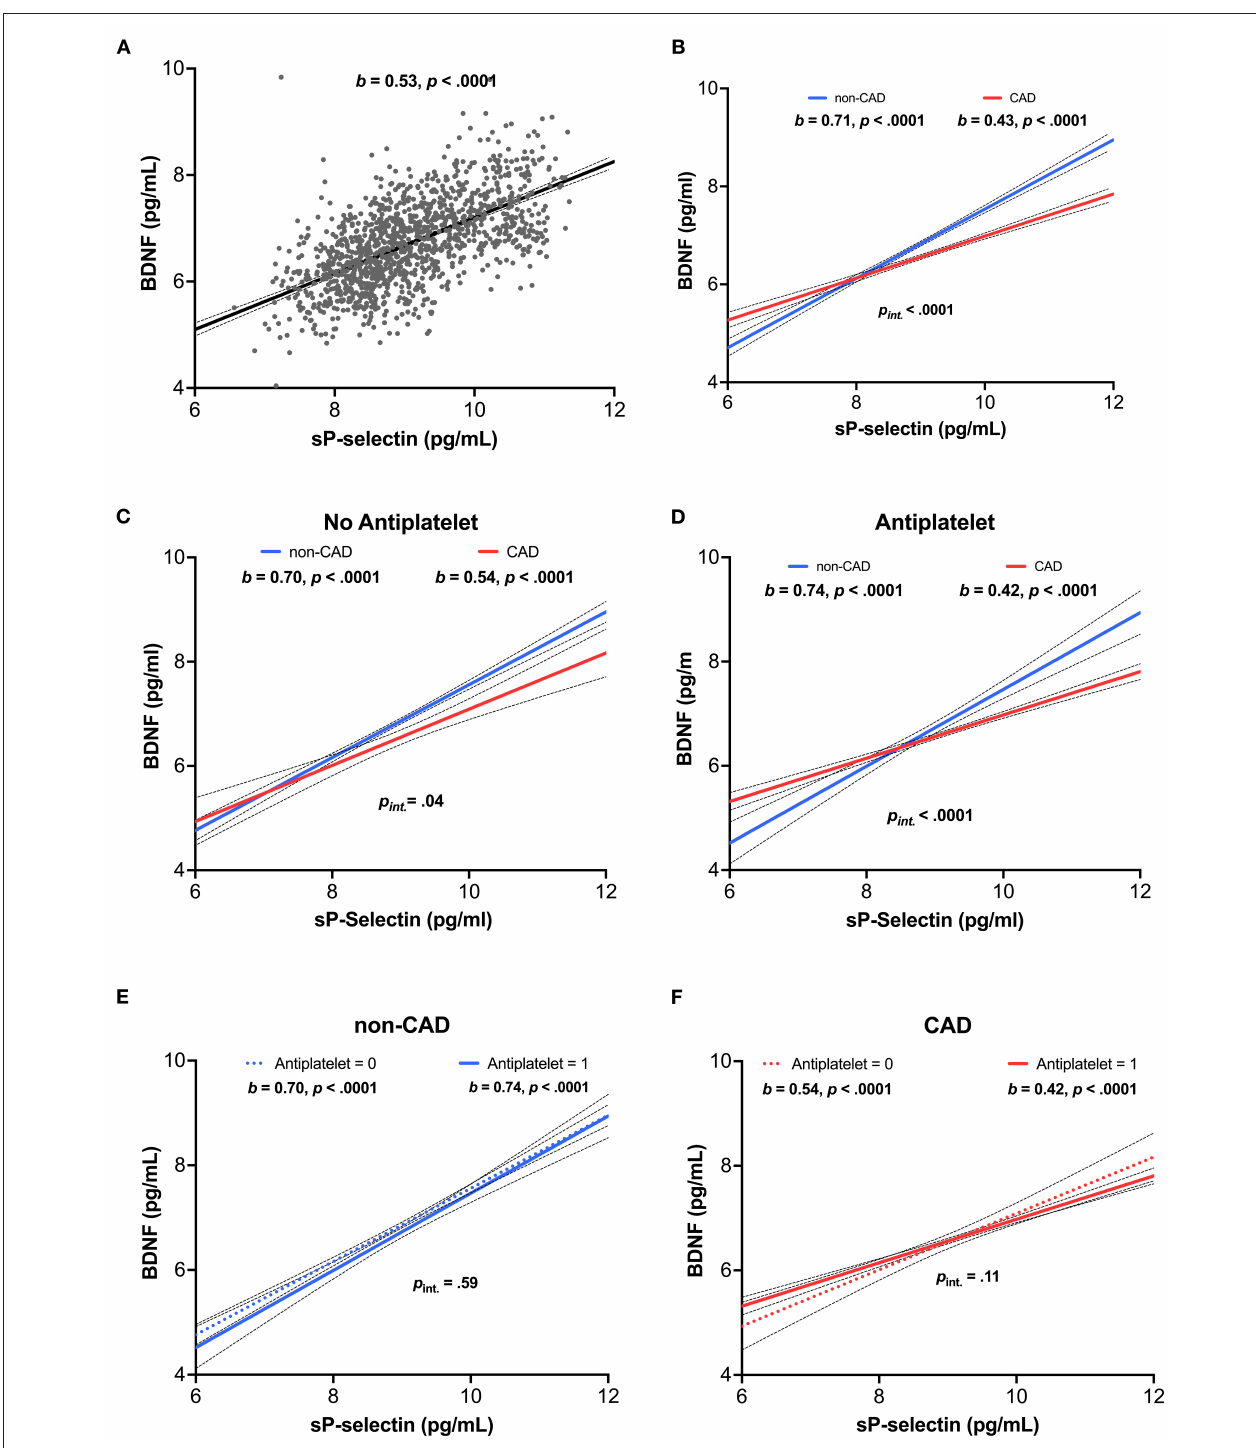
FIGURE 2 | Relationship between platelet activity and BDNF concentrations. (A) Association of sP-selectin to BDNF concentrations in the overall population ( n = 1,280). (B) Interaction with CAD status. Association of sP-selectin to BDNF concentrations in subjects (C) without and (D) with antiplatelet therapy. (E,F) Interaction with antiplatelet medication. sP-selectin and BDNF concentrations were log-transformed to account for a skewed distribution. b: unstandardized coefficient.